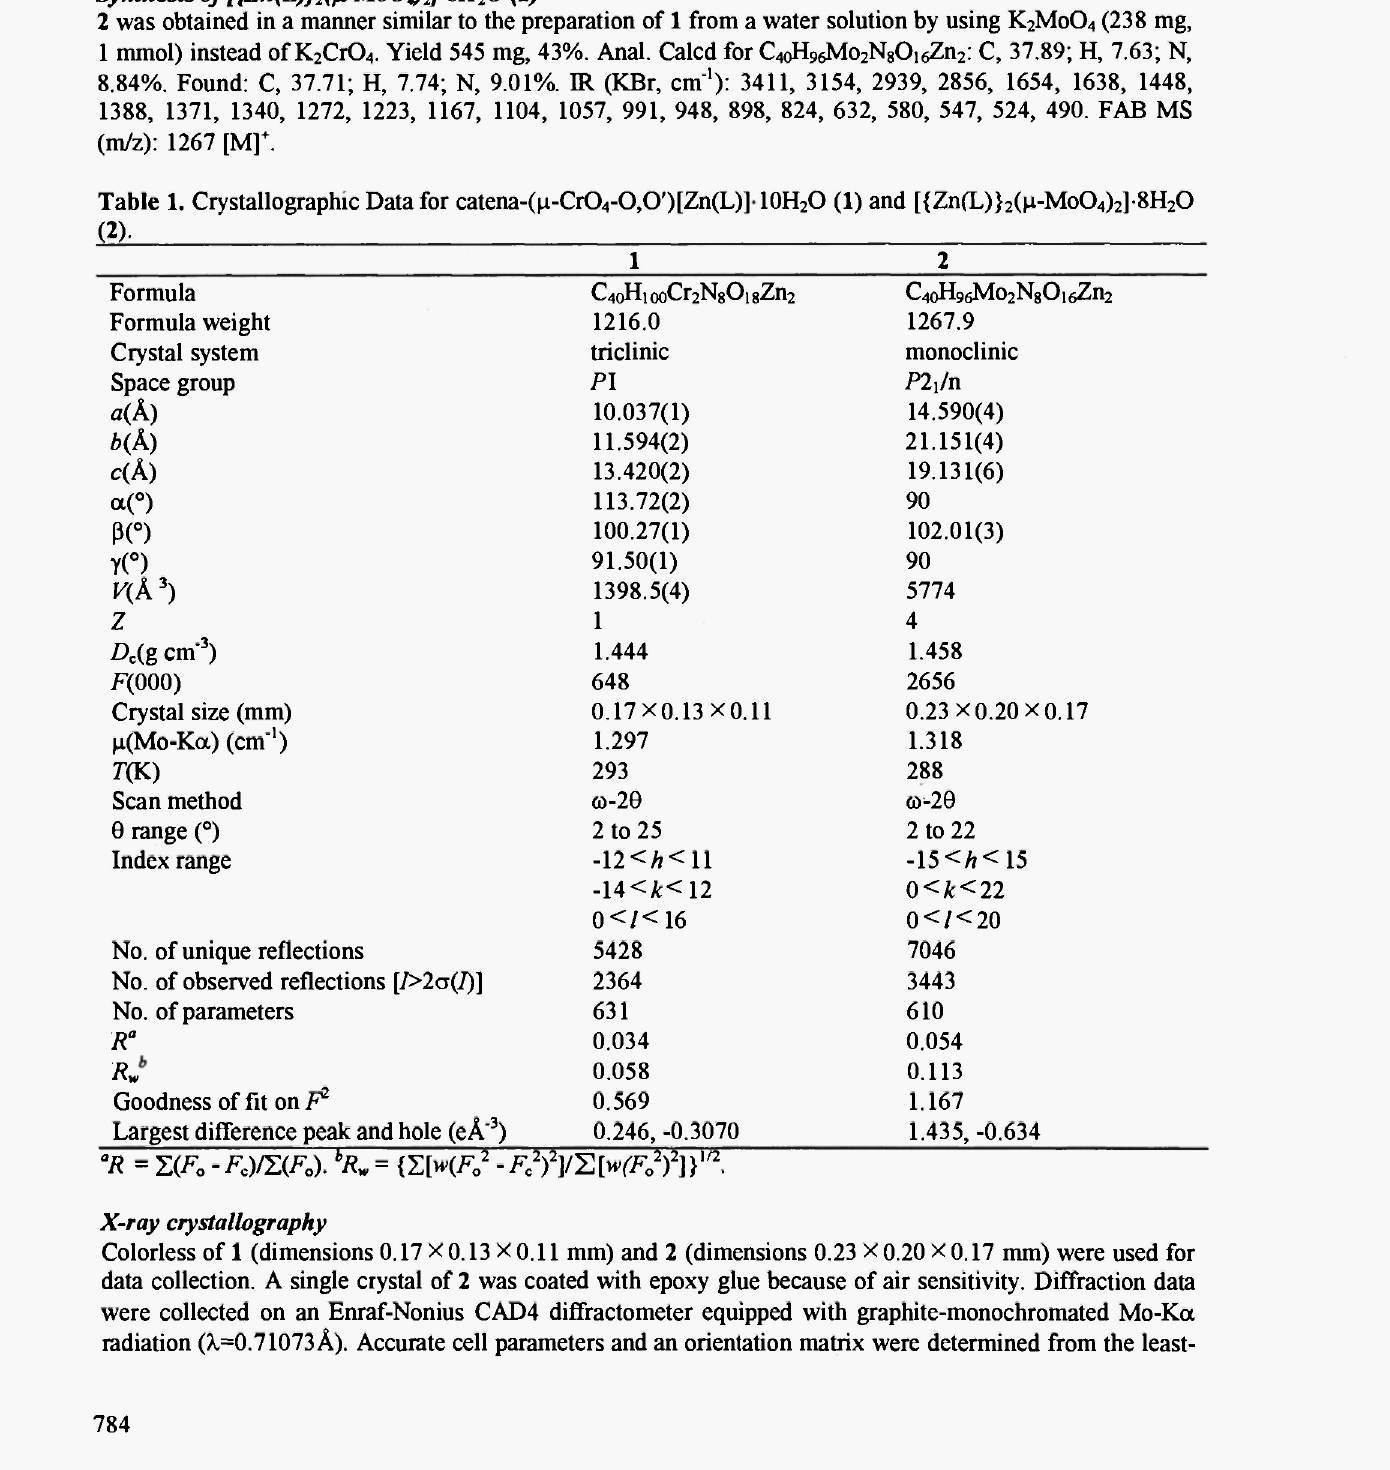
Table 1. Crystallographic Data for catena-^-Cr0 4 -0,0')[Zn(L)]10H 2 0 (1) and [{Ζη(Τ)} 2 (μ-Μο0 4 ) 2 ]·8Η 2 0